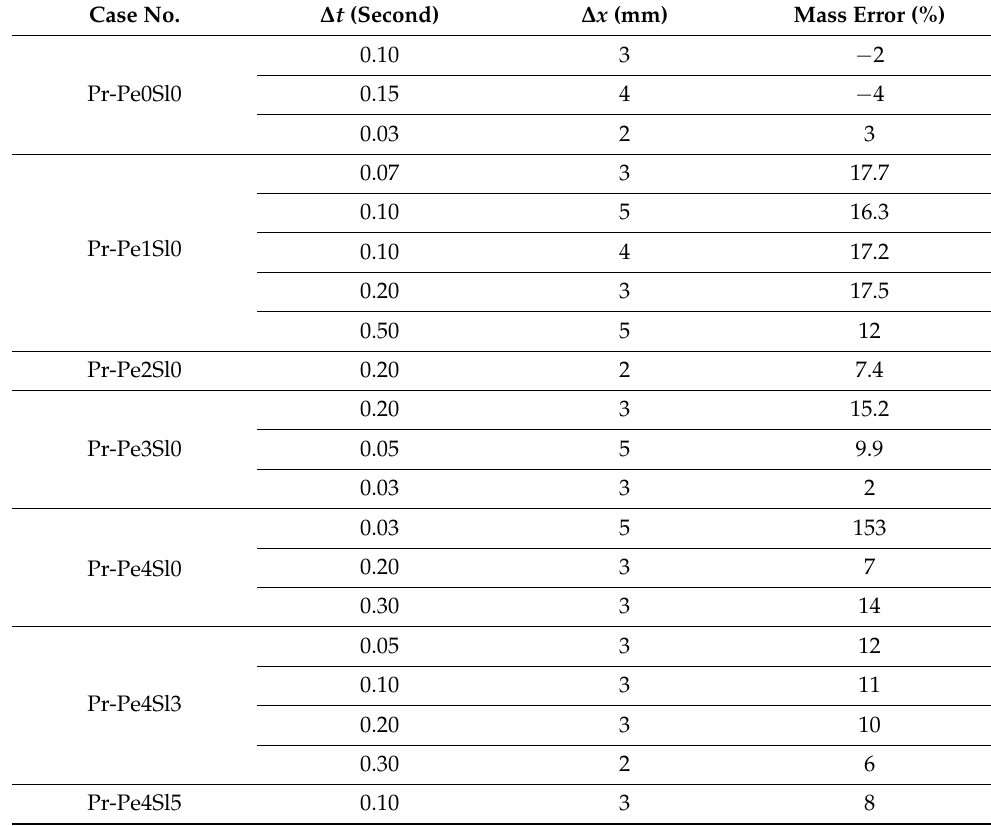
Table 6. Results of mass conservation error of prototype model (with respect to time and space